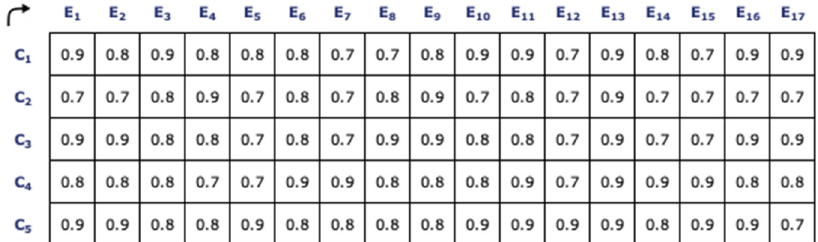
Figure A3. Matrix with a valuation of incidents between effects.